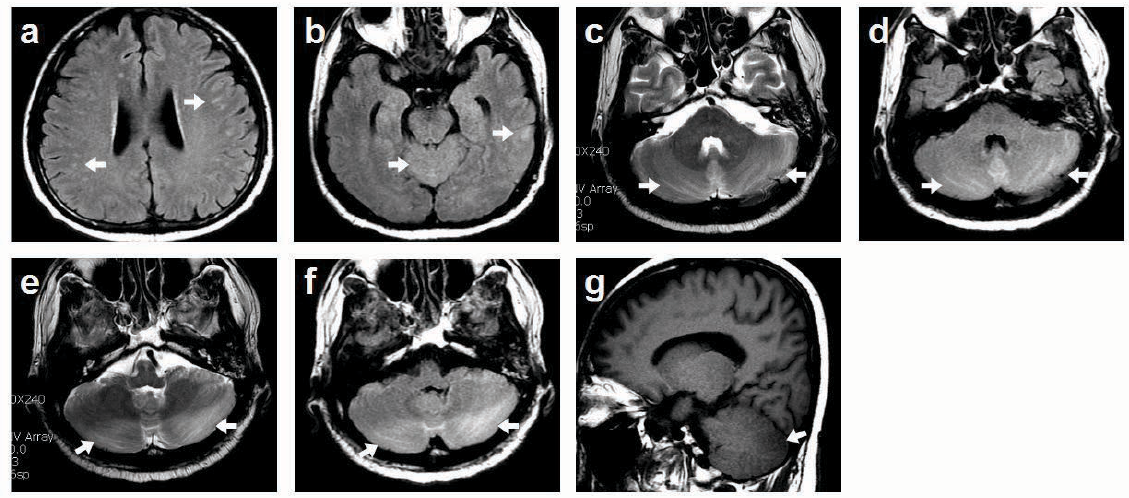
Figure 1. A brain magnetic resonance imaging (MRI) scan was performed on day 36 of hospitalization. Fluid-attenuated inversion recovery (FLAIR) images showed several small hyperintense lesions in both cerebral hemispheres (a, b). In addition, brain MRI demonstrated lesions in both hemispheres of the cerebellar cortex slightly hyperintense on T2-weighted (c, e) and FLAIR (b, d, f) images and hypointense on T1-weighted images with swelling